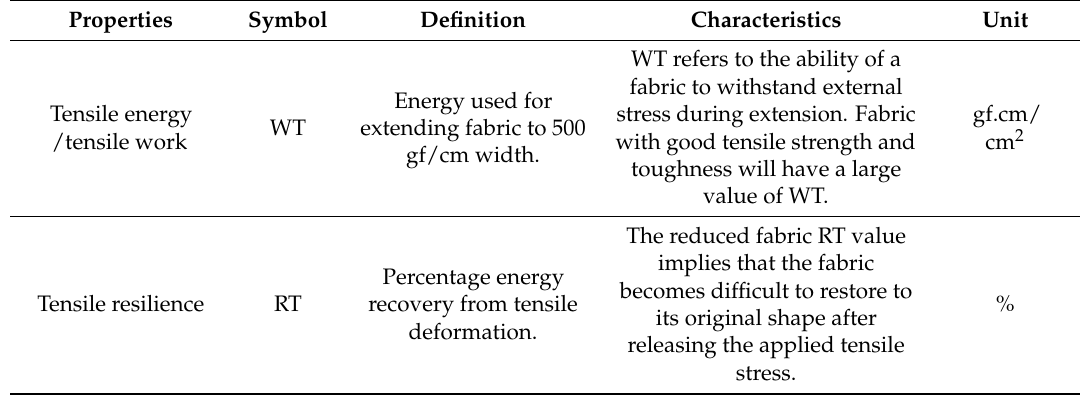
Table 2. Low-stress mechanical properties in KES-F system